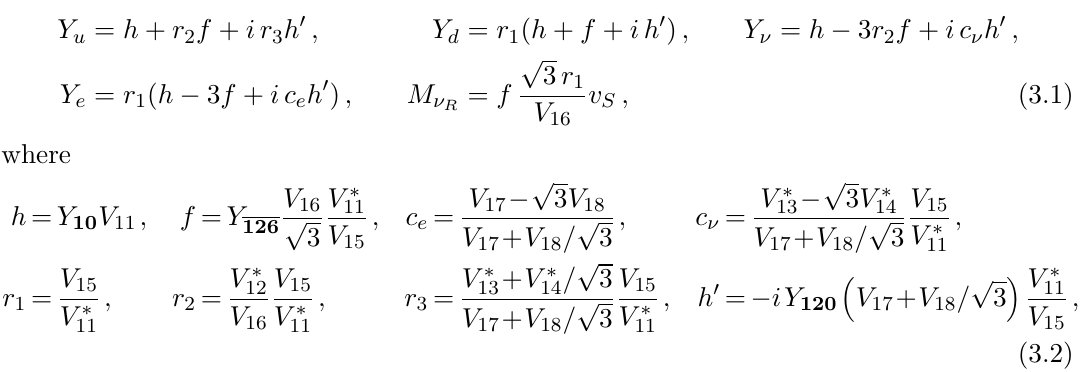
and M , as well as gauge couplings α 3 X X